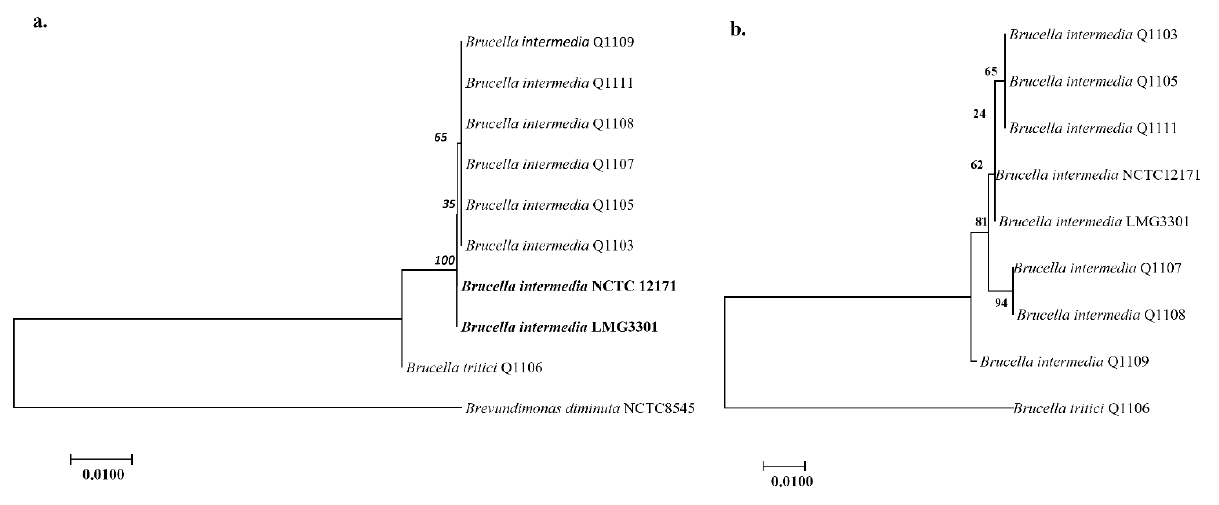
Figure 1. Phylogenetic trees showing the clustering of B. intermedia strains based on 16S rRNA ( a ) and RecA ( b ) genes using the maximum likelihood method. The scale bar represents a 1% sequence divergence. Brevundimonas diminuta NCTC 8545 was used as outgroup for the 16S rRNA gene. Species in bold letters indicate those for which genomes were downloaded from GenBank.